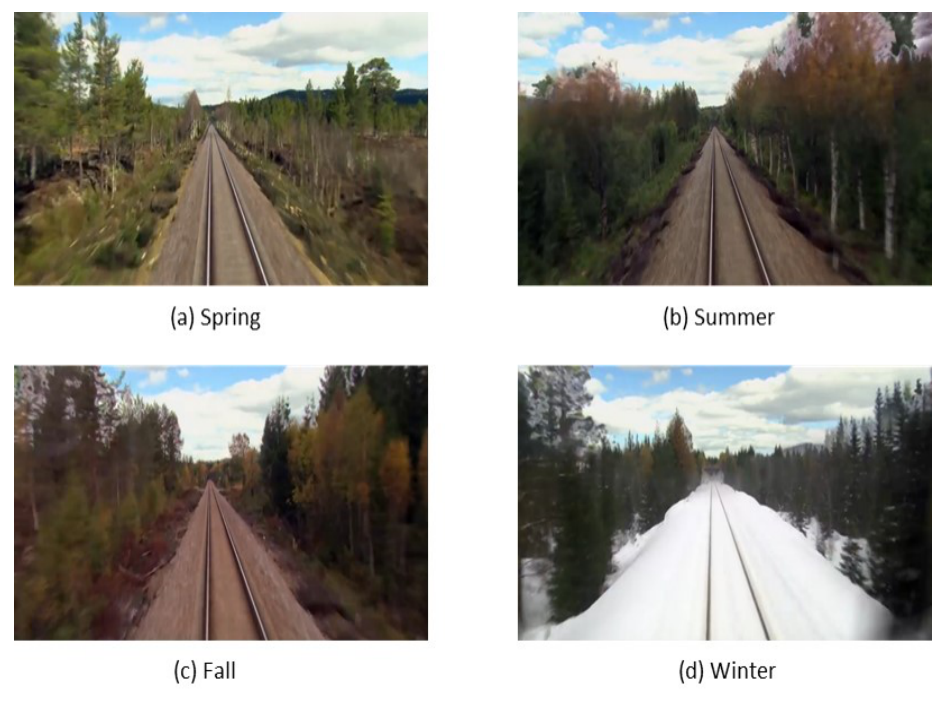
Figure 4. Typical four season images representing the same scene in spring, summer, fall and winter. It can be seen that huge differences appear in the images with seasons